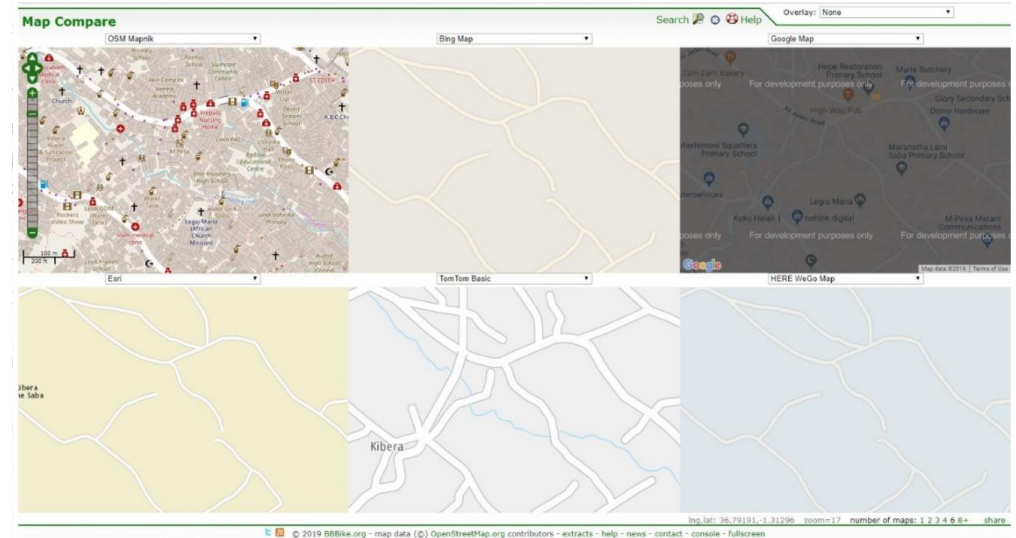
Figure 1. Nairobi and surrounding area on six map services at scale 1:35,000.